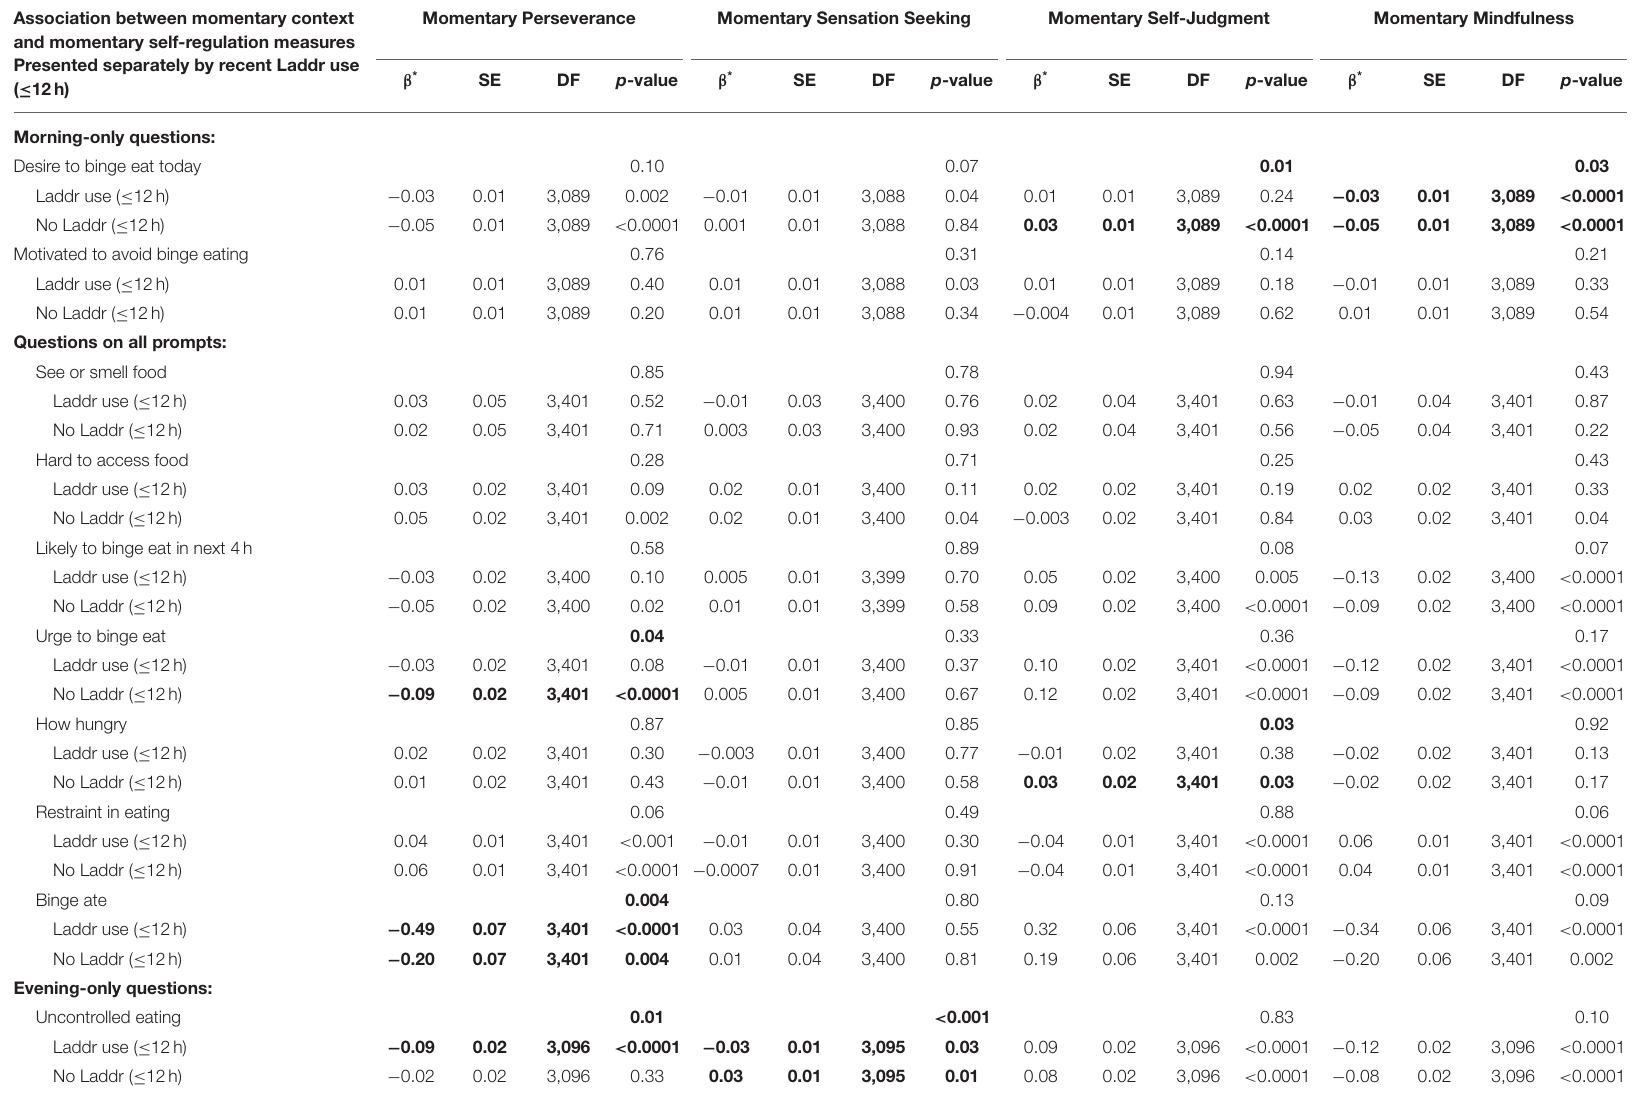
TABLE 8 | Momentary context measures, association with momentary self-regulation by recent Laddr use ( ≤ 12h) in the binge-eating sample. Association between momentary context and momentary self-regulation measures Presented separately by recent Laddr use ( ≤